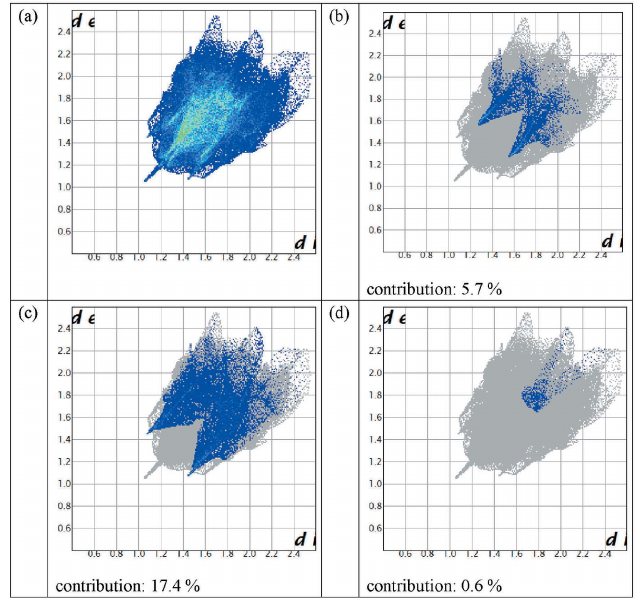
Figure 7 The two-dimensional fingerprint plot of the title compound ( a ) full and decomposed into ( b ) H (cid:2)(cid:2)(cid:2) O/O (cid:2)(cid:2)(cid:2) H contacts, ( c ) H (cid:2)(cid:2)(cid:2) N/N (cid:2)(cid:2)(cid:2) H contacts and ( d ) N (cid:2)(cid:2)(cid:2) N